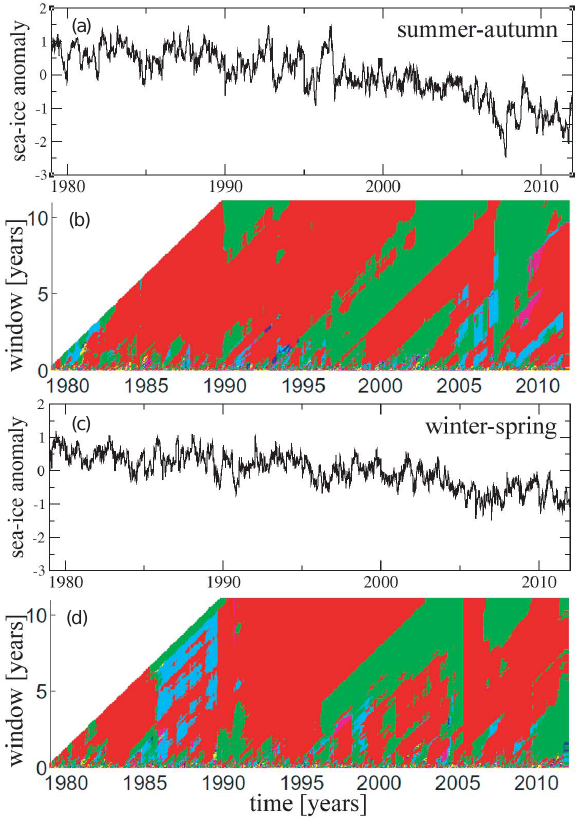
Fig. 7. Potential analysis of summer–autumn and winter–spring Arctic sea-ice area data. (a) Summer–autumn sea-ice area anomaly, daily data with mean cycle removed. (b) Contour plot of number of detected states. (c) Winter–spring sea-ice area anomaly, daily data with mean cycle removed. (d) Contour plot of number of detected